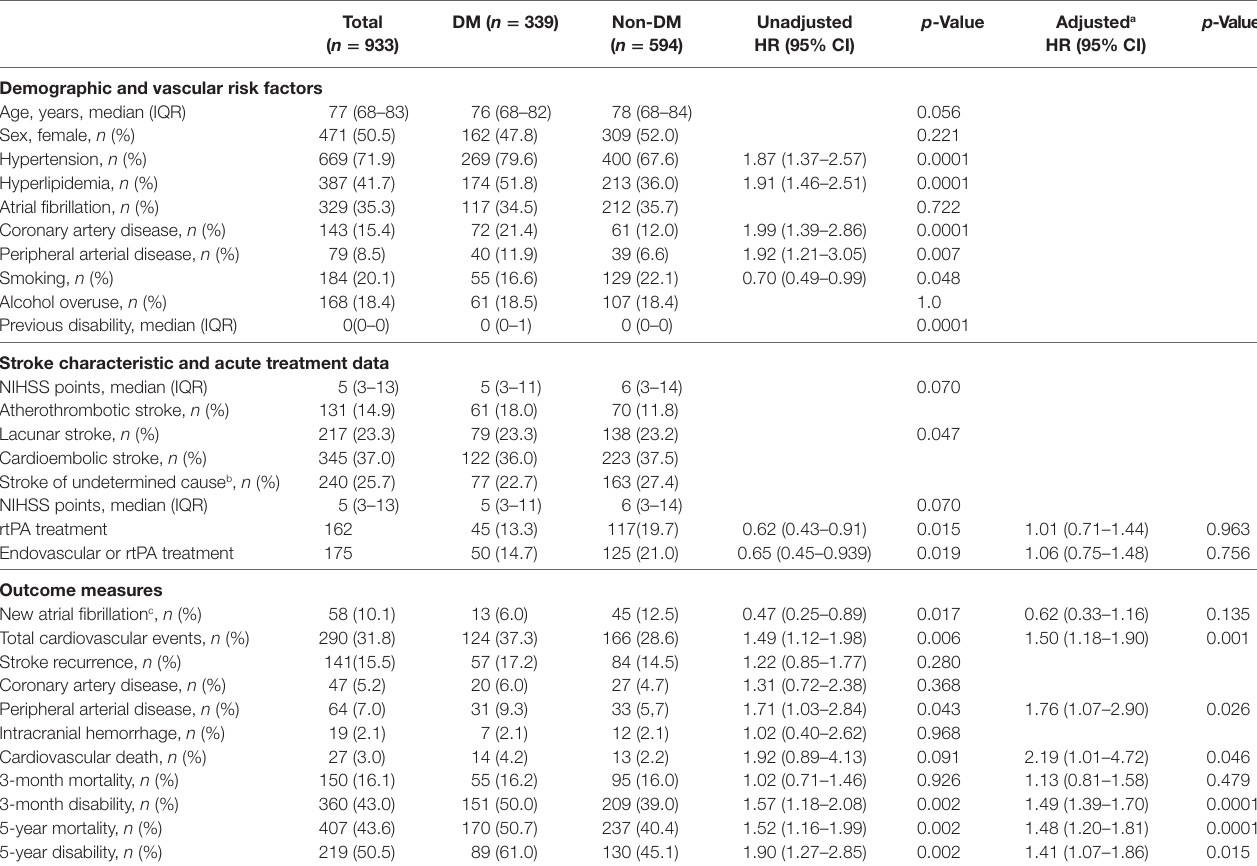
TaBle 1 | Differences between diabetic and non-diabetic patients.